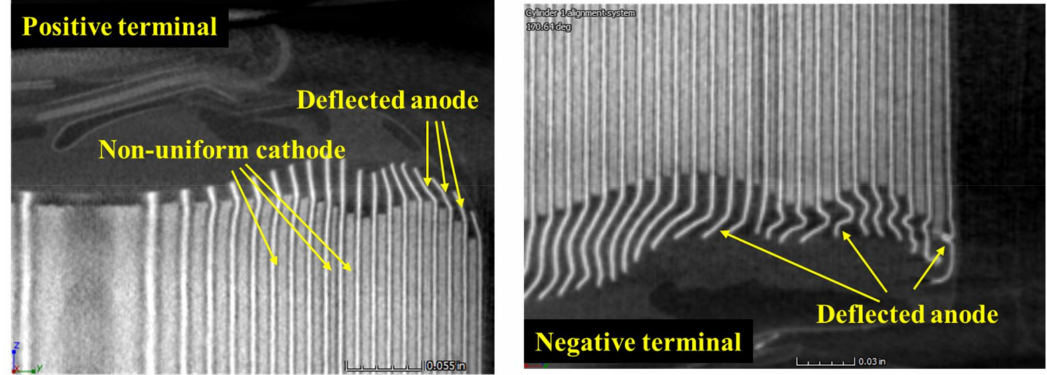
Figure 19. CT scan images near the positive and negative terminals of the sample